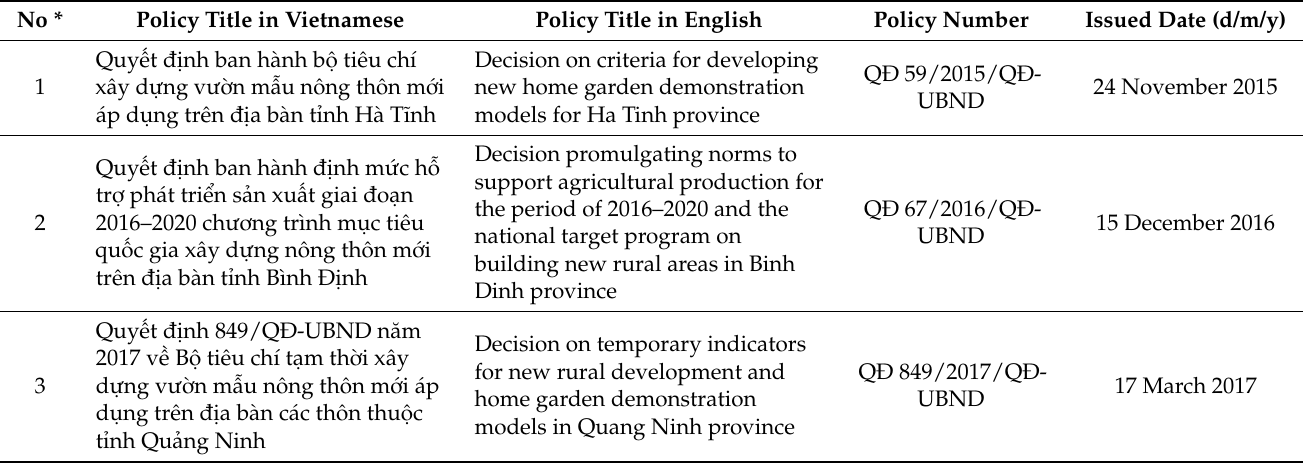
Table A2. The 25 home garden policies enacted over the last decade